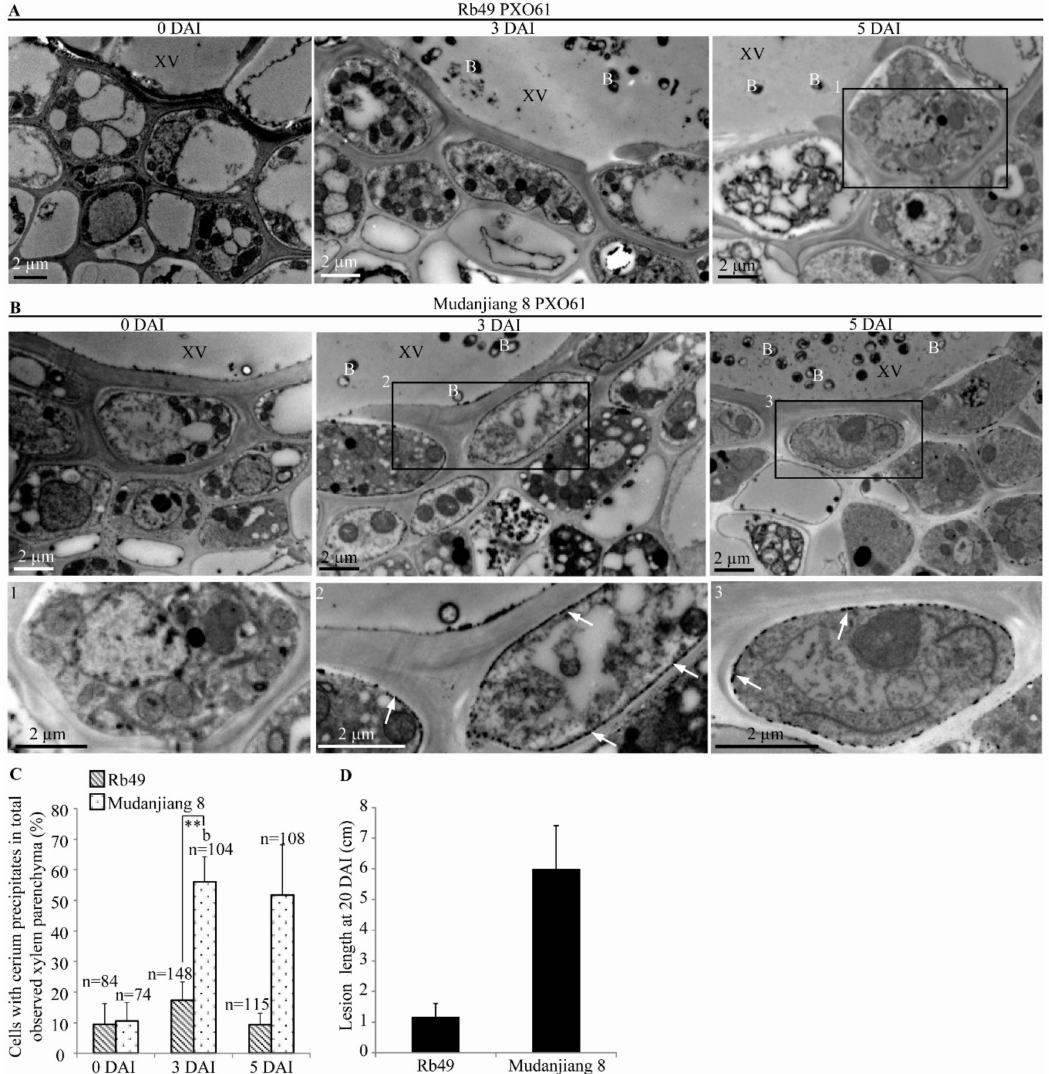
Figure 6. Subcellular localization of H 2 O 2 in xylem parenchyma cell in Xa3 / Xa26- mediated resistance. XV, xylem vessel; B, Xoo bacterium; White arrow, high electron-density cerium peroxide precipitates. ( A ) Small number of high electron-density cerium peroxide precipitates (H 2 O 2 ) on plasma membrane of xylem parenchyma cells in Rb49 plants inoculated by Xoo strain PXO61 at 0, 3, 5 DAI. In Figure A, 1 represents the enlarged xylem parenchyma cells in the 1st rectangle. ( B ) Large number of high electron-density cerium peroxide precipitates (H 2 O 2 ) on plasma membrane of xylem parenchyma cells in Mudanjiang 8 plants infected by PXO61 at 3, 5 DAI, in contrast with no cerium peroxide precipitates at 0 DAI. In Fig.B, 2, 3 represents the enlarged xylem parenchyma cells in the 2nd, 3rd rectangle. ( C ) Percentage of cells with cerium peroxide precipitates on plasma membrane in all the observed xylem parenchyma cells. Data represent mean (74-115 xylem parenchyma cells of three xylem vessels from three di ff erent plants) + standard deviation (SD). Double asterisks (**) indicate significant di ff erence ( p < 0.01) in the number of xylem parenchyma cell between Rb49 and Mudanjiang 8 at 3 DAI. Letter “b” indicates statistically significant di ff erence between 0 day and other time in the same rice plant at p < 0.05. n, the number of all the observed cells. ( D ) Lesion length of Rb49 and Mudanjiang 8 leaves infected by Xoo at 20 DAI. Each bar represents mean (11–15 leaves from four plants) +